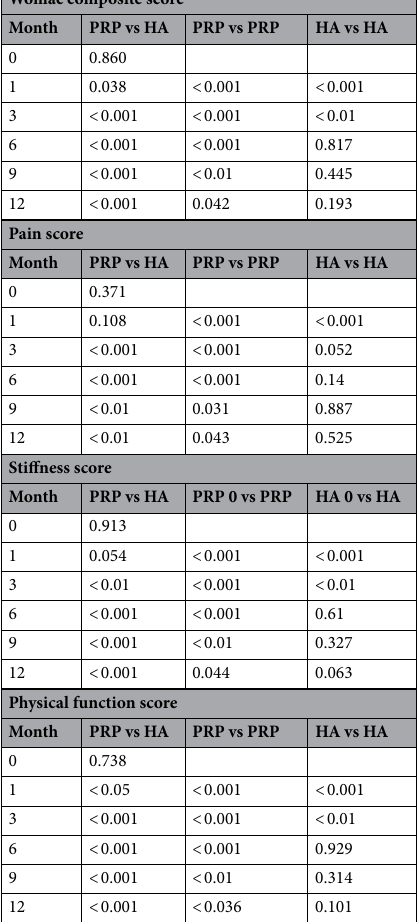
Table 2. Statistical analysis of WOMAC scores of patients in PRP (n = 64) and placebo HA (n = 68) groups over 1 Year of follow-up. WOMAC Western Ontario and McMaster Universities Arthritis Index: scores are in mean ± SD (95% CI; confidence